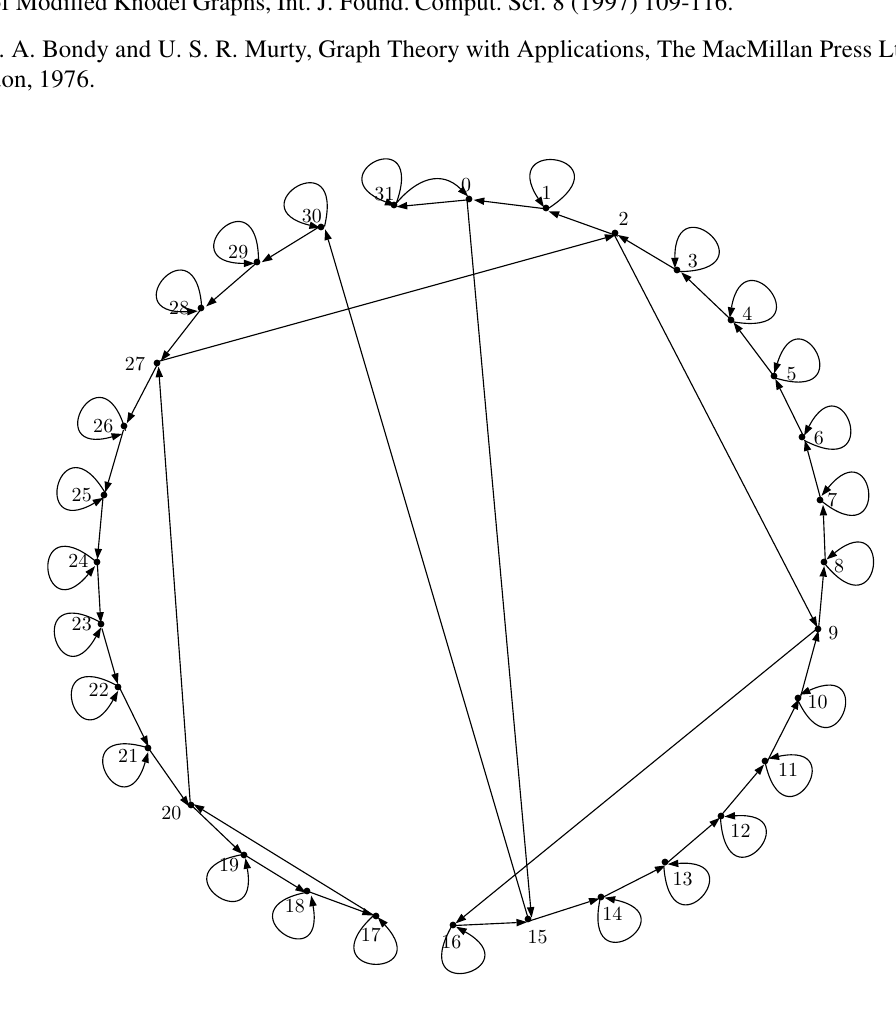
Fig. 10: A spanning 2 -diregular bieulerian subdigraph ~H 0 of ~G ′ 6